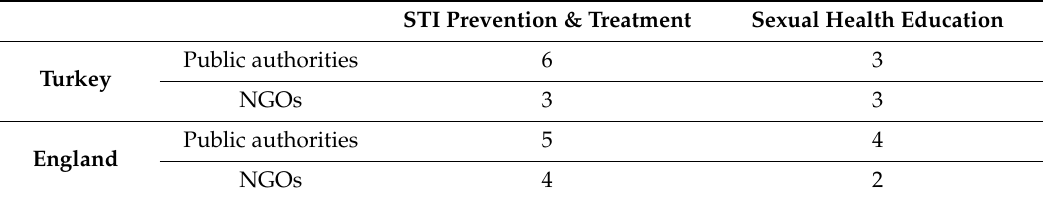
Table 1. The breakdown of documents